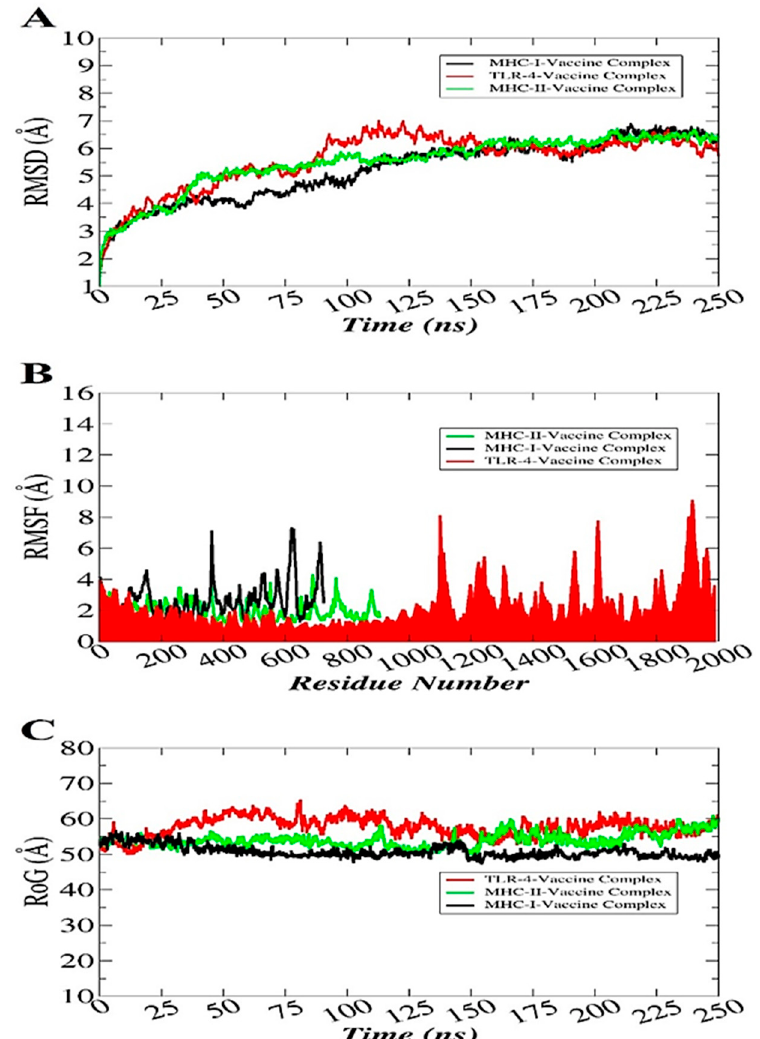
Figure 9. Statistical analysis of the simulation trajectories. RMSD ( A ), RMSF ( B ), and RoG ( C ).